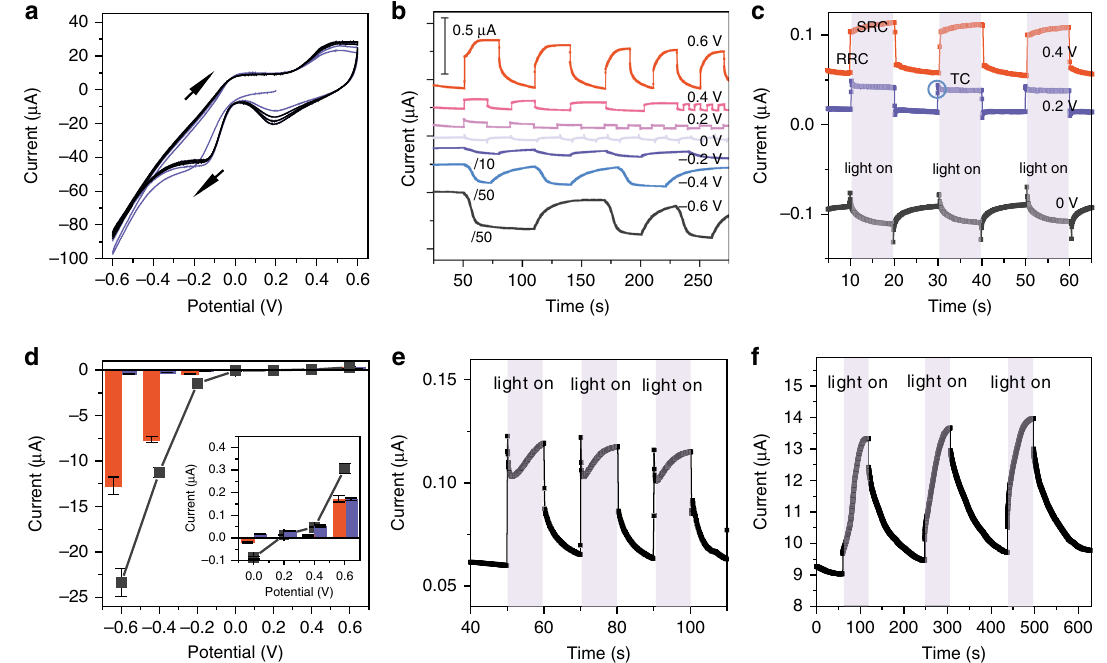
Fig. 2 The photo-electrochemical properties of the plasmonic electrode. a The typical CV curve of Au nanoelectrode array. b The photocurrent of the Au nanoelectrode array at different applied potentials, and the current-time curves at negative potentials have been divided by 10 for − 0.2 V and 50 for − 0.4 and − 0.6 V. c The current-time curves of the Au nanoelectrode array at 0.4 V, 0.2 V, and 0 V. The current changed immediately when illuminating the electrode, and the plasmonic photocurrent could be divided in two parts according to the response time: the RRC (0.05 s) and the SRC (10 s). The transient current (TC) is marked by blue cycle. d The background current, RRC (blue) and SRC (red) as a function of applied potential. The background current is the dark current without the illumination. The RRC corresponds to the current change in the fi rst 0.05 s. The SRC corresponds to the current change in the next 10 s for the case showing transient current, the SRC was calculated after the transient response. e Typical photocurrent of Au nanoelectrode array at 0.6 V in deaerated 0.2 M sodium sulfate electrolyte. f Typical photocurrent of Au nanoelectrode array at 0.4 V in deaerated 0.25 mM ferrocenemethanol solution. The error bars represent the standard